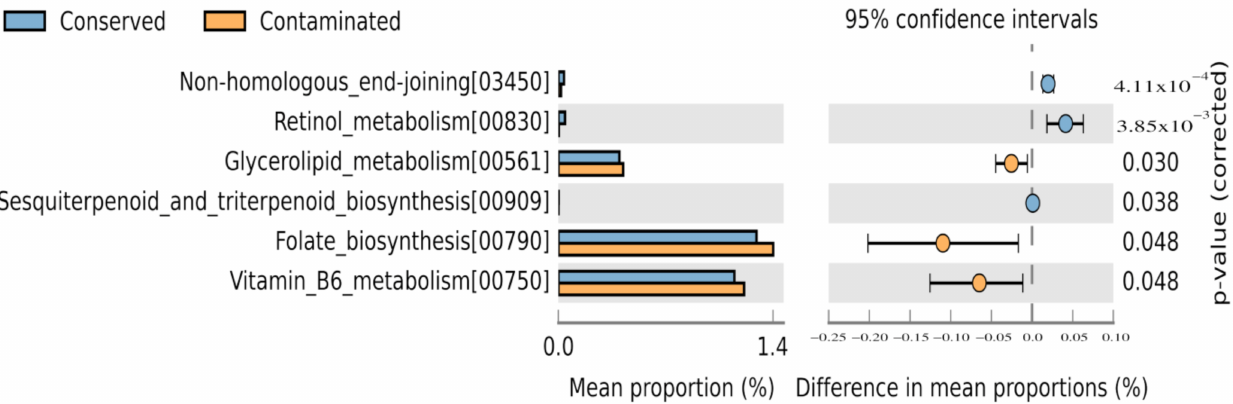
Figure 6. Metabolic pathways profile comparisons between conserved sites (Bocas de Dzilam and El Palmar) and contami- nated sites (Progreso and Sisal) using STAMP analysis. Analyses were carried out at level 3 of specific pathway associated with a specific function using KEGG. Blue bar: conserved sites; orange bar: contaminated sites. The standard deviation is shown as a bar in the